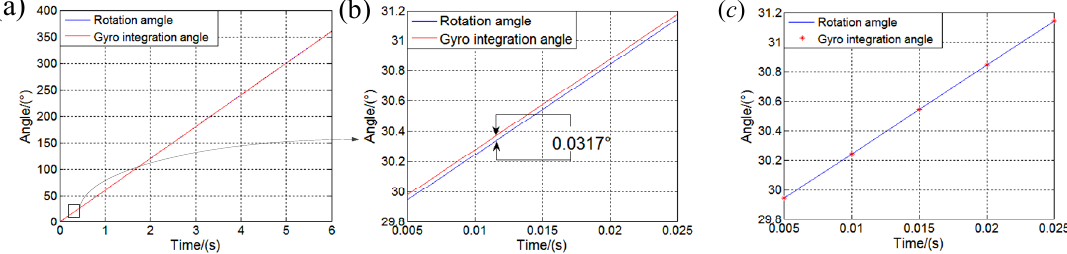
Figure 9. Unsynchronized time compensation results. ( a ) Before compensation; ( b ) Partial enlargement of (a); ( c ) Results after compensation.